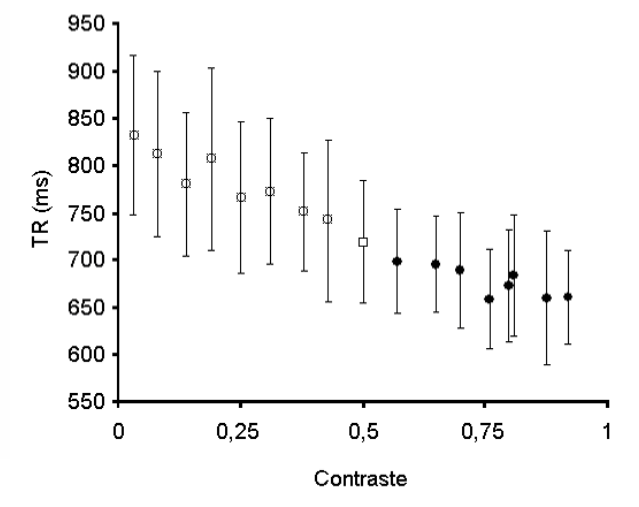
Figura 2 . Tempo de reação dos participantes em função do contraste da luminância entre os estímulos relevantes e a textura. A medida de disper- são representa o erro-padrão em cada condição. ( ) TR médio com con- traste superior à 0,5= 677 ms; ( ) TR médio com contraste igual à 0,5= 719 ms; ( ) TR médio com contraste inferior à 0,5= 783